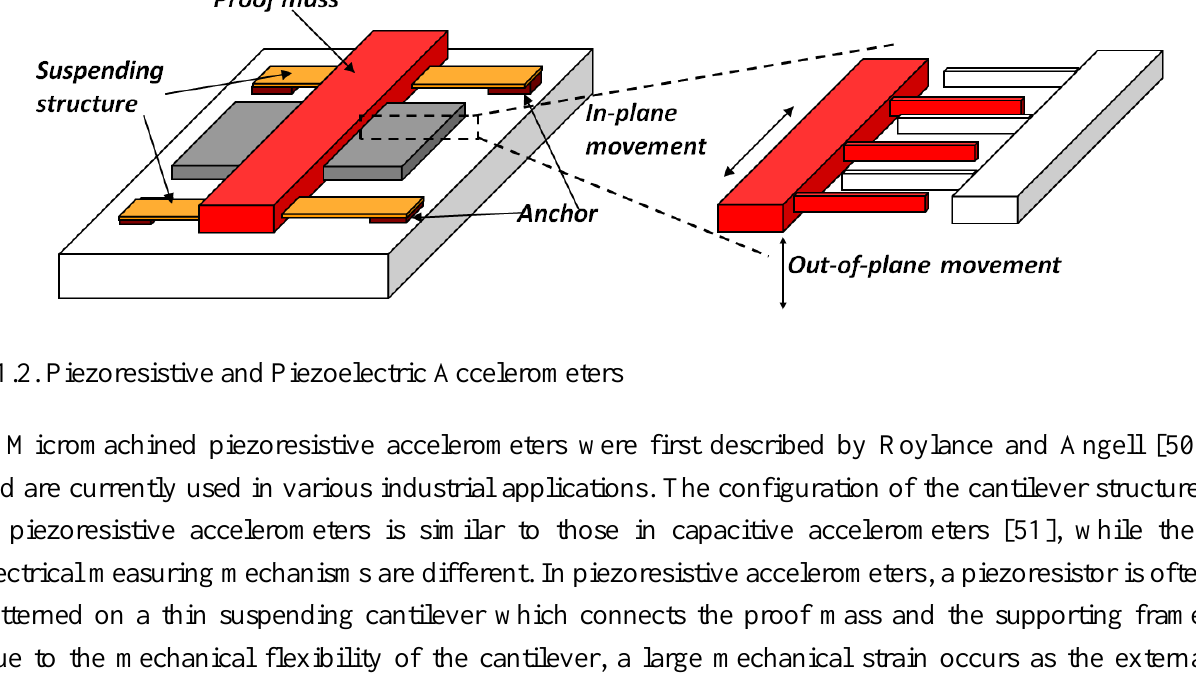
Figure 5. Schematic of the capacitive measurement of the proof mass